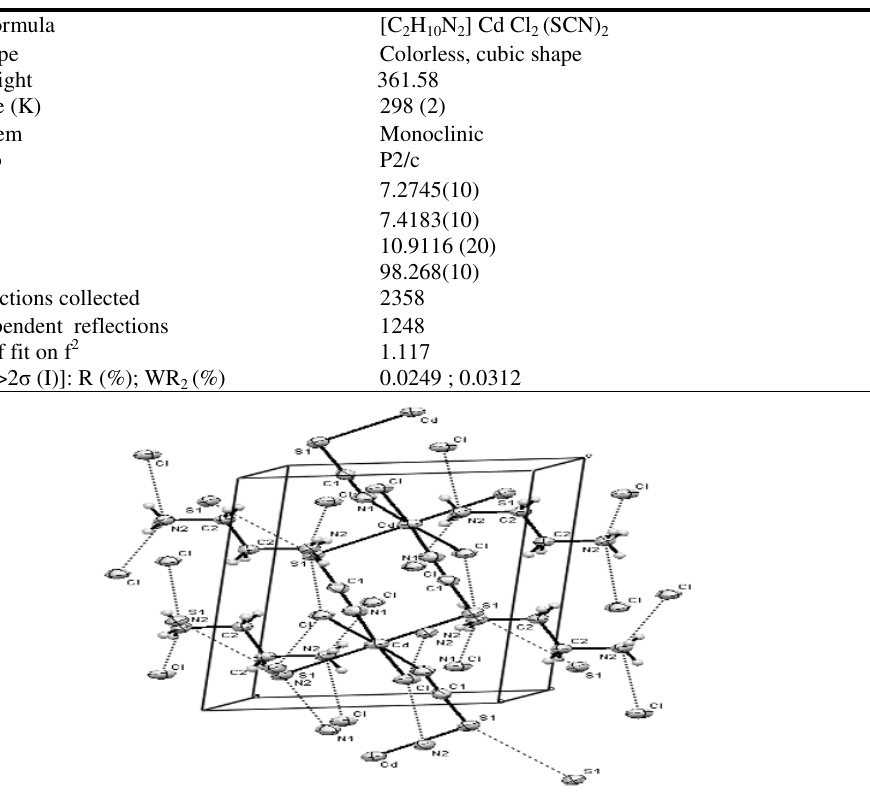
2 H 10 N 2 ] Cd Cl 2 (SCN) 2